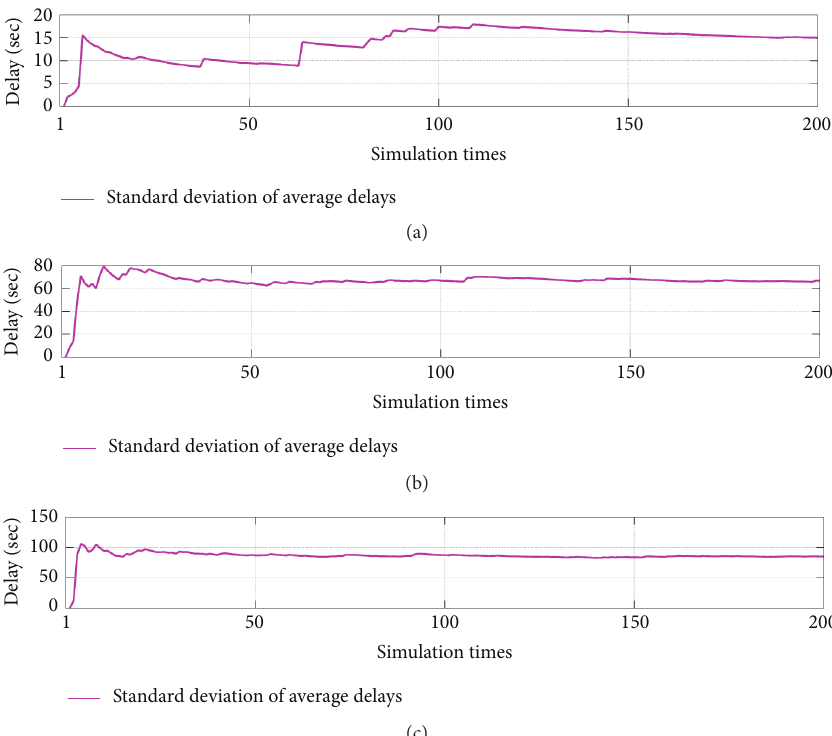
Figure 12: Standard deviation of the average delays with different simulation times (a) when 1000 cars arrive, (b) when 2000 cars arrive, and (c) when 3000 cars